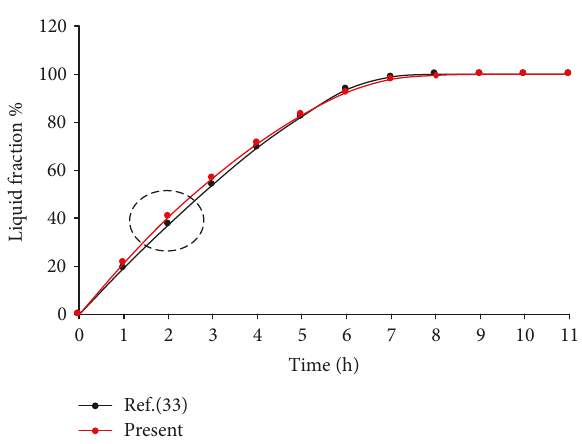
Figure 2: Comparison between the present result and the result of literature Ref. [32].